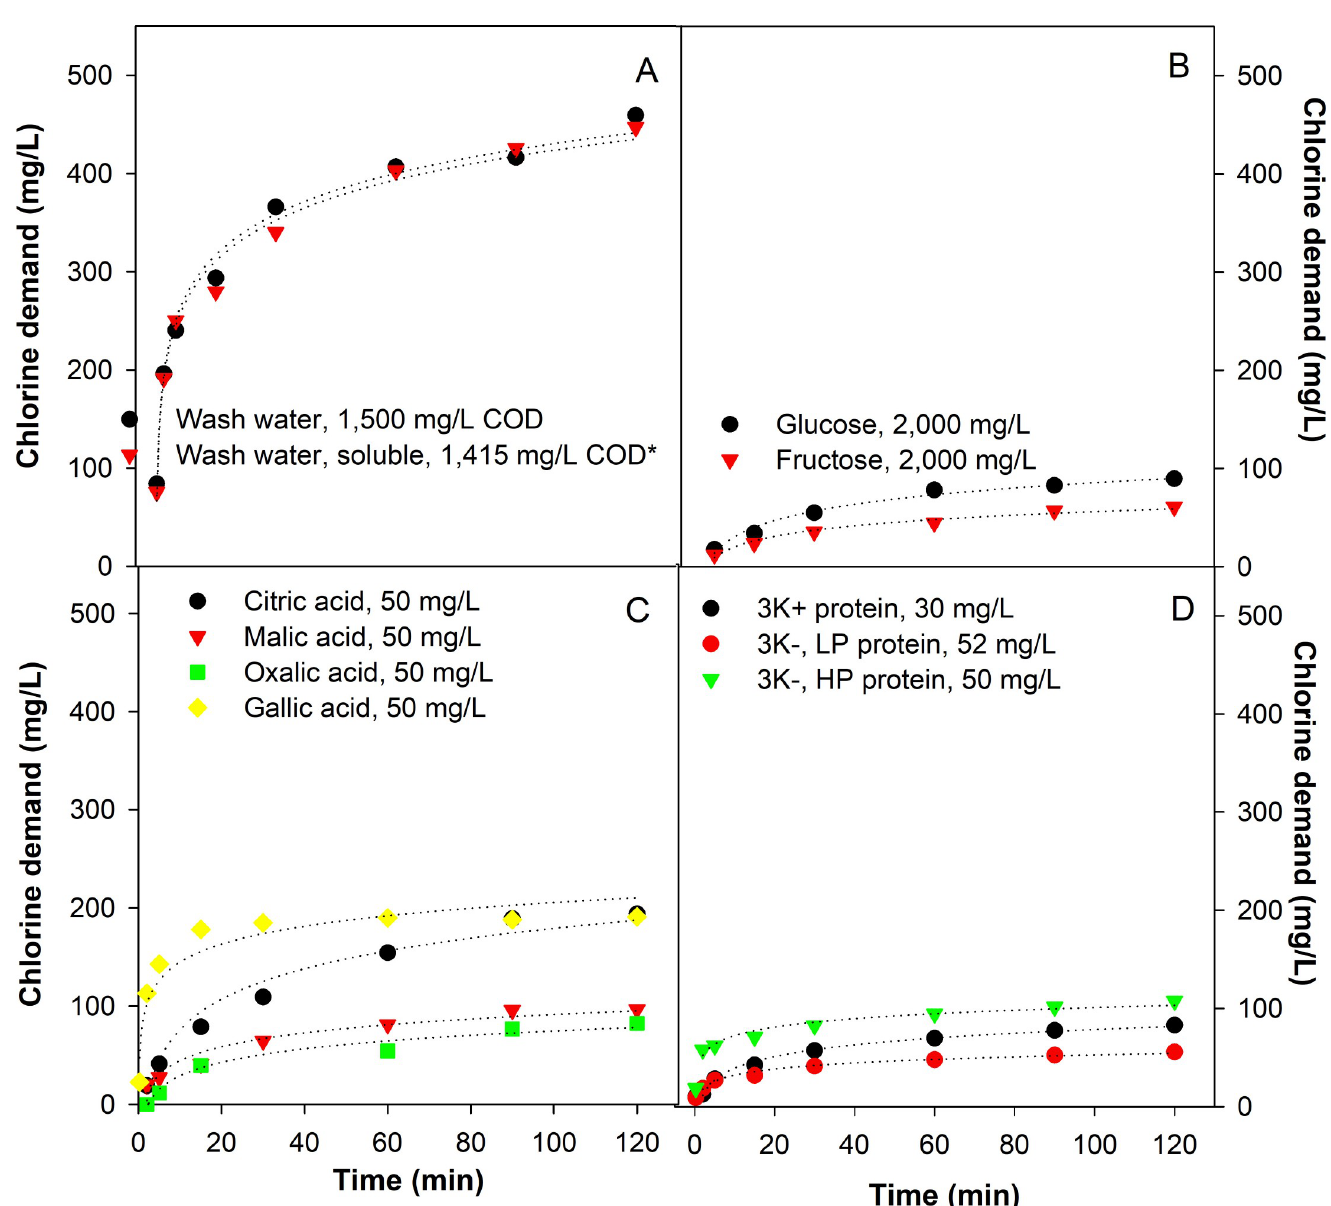
Fig 2. Time- and concentration-dependent chlorine demand (CLD) of different compounds identified in this study. Fig 2A–2D show the time-dependent CLD of cabbage wash water (A) and its constituents: sugars (B), organic acids and phenols (C), and proteins (D). The concentration of compounds shown in the figures represent the approximate concentrations in the standardized wash water (COD = 1,500 mg/L). Data for more concentrations are available in S1 Fig. Fig 2E and 2F show the concentration-dependent chlorine demand (CLD) of different compounds identified in this study. Chlorination time was 15 (left) and 120 (right) min. Values on x-axis denote for substrate concentration. Data for more times are available in S2